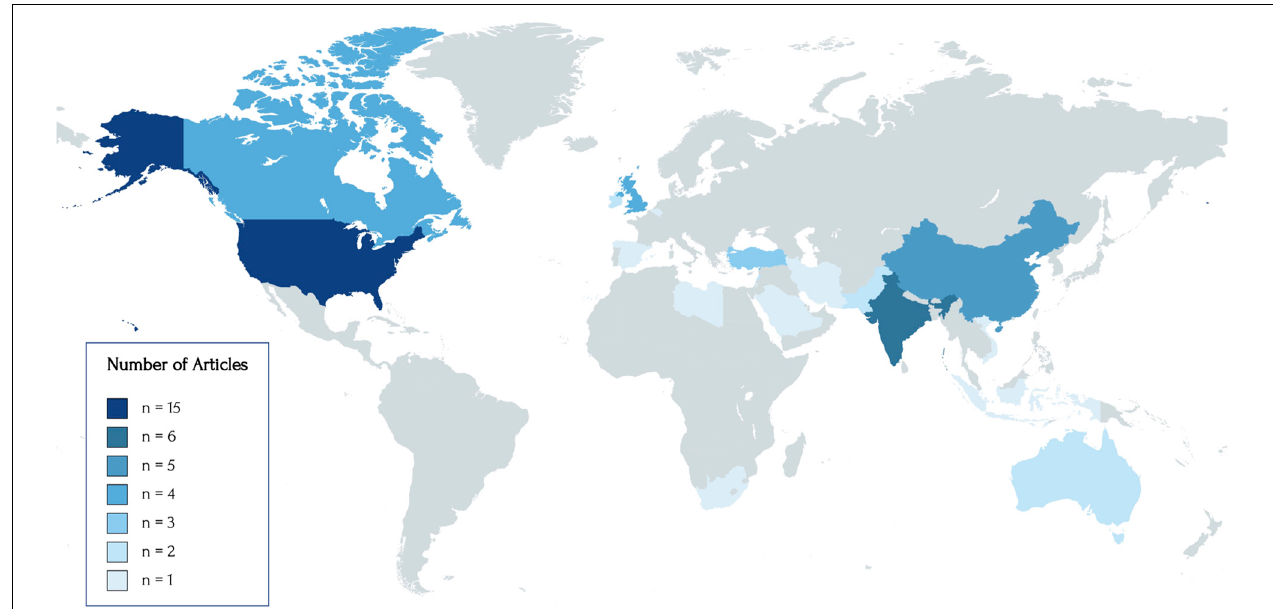
FIGURE 2 | World map of the geographical distribution of included studies. The following geographies were represented: United States ( n = 15), India ( n = 6), China ( n = 5), Canada ( n = 4), United Kingdom ( n = 4), Turkey ( n = 3), Australia ( n = 2), Ireland ( n = 2), Lebanon ( n = 2), Pakistan ( n = 2), Belgium ( n = 1), Indonesia ( n = 1), Iran ( n = 1), Libya ( n = 1), Palestine ( n = 1), Saudi Arabia ( n = 1), South Africa ( n = 1), Spain ( n = 1), and Vietnam ( n = 1). Two studies conducted with global participants and one study conducted on North American participants were not included in the following